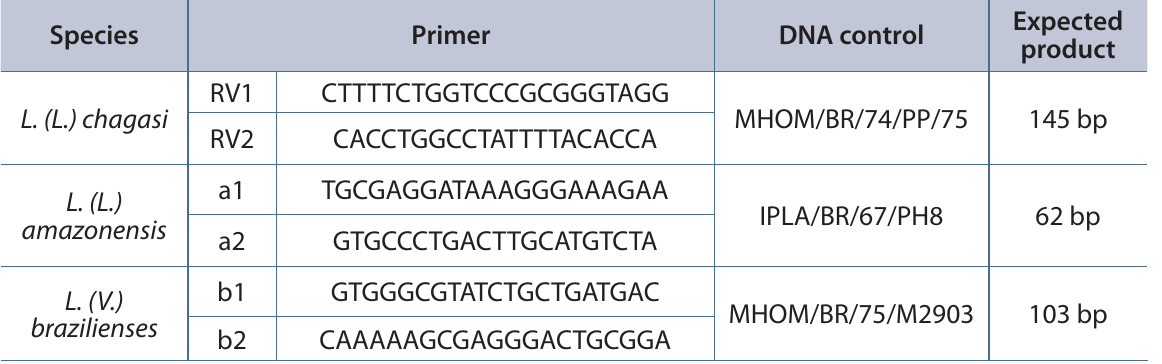
Table 1. Primers and DNA controls for the species L. (L.) chagasi, L. (L.) amazonensis and L. (V.) braziliensis used in PCR for identification of Leishmania DNA in the saliva of patients with ACL Species Primer DNA